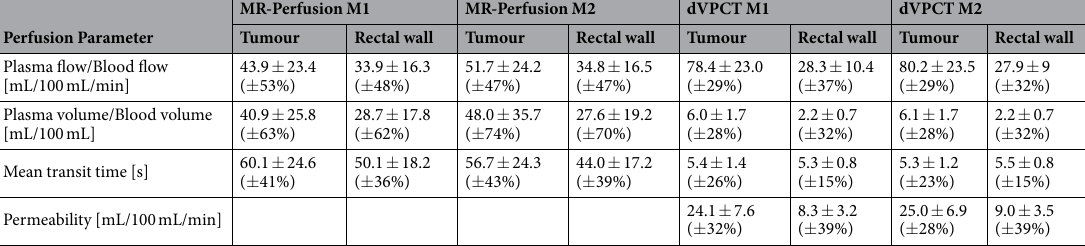
Table 2. Variability of perfusion measurements in tumour tissue and normal rectal wall with MR-Perfusion vs. dVPCT. Legend: Data means ± standard deviation ( ± coefficient of variation